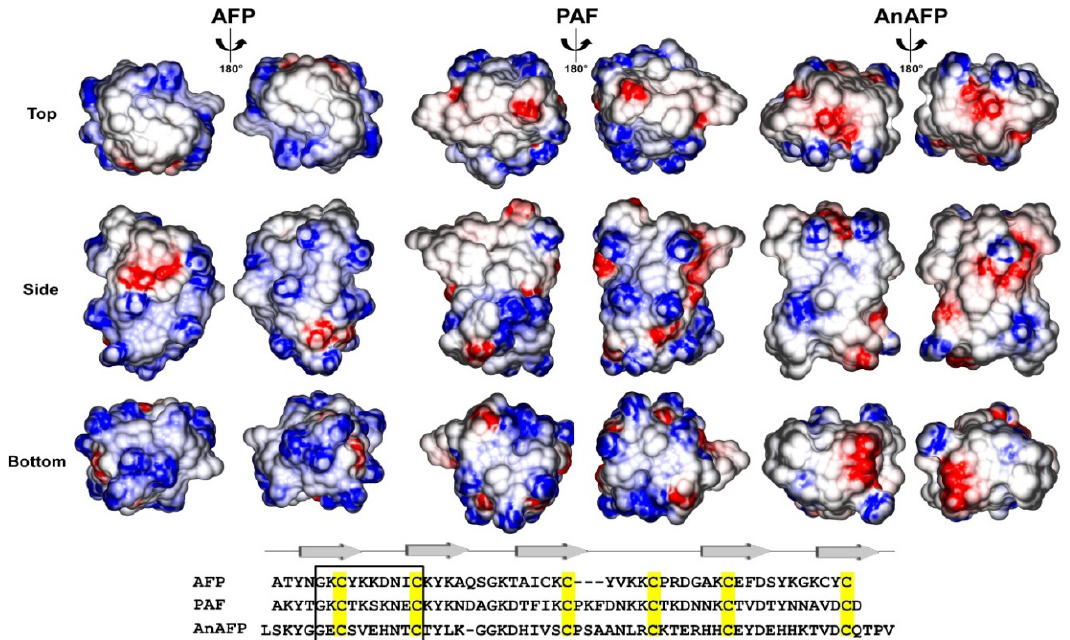
Figure 1. Electrostatic surface potentials of AFP, PAF, and AnAFP. AFP and PAF were derived from PDB accession codes 1AFP or 1KCN, respectively, whereas the structure of AnAFP was generated by molecular modeling using the structure of AFP as the template. Negatively charged regions are colored red, positively charged ones blue, and uncharged ones white. Graphical representations displaying top, side, and bottom views of the peptides were generated using the program GRASP2 [11]. An alignment of AFP, PAF, and AnAFP is given below. The box depicts residues of the γ -core motif. Arrows on top represent beta-strands.